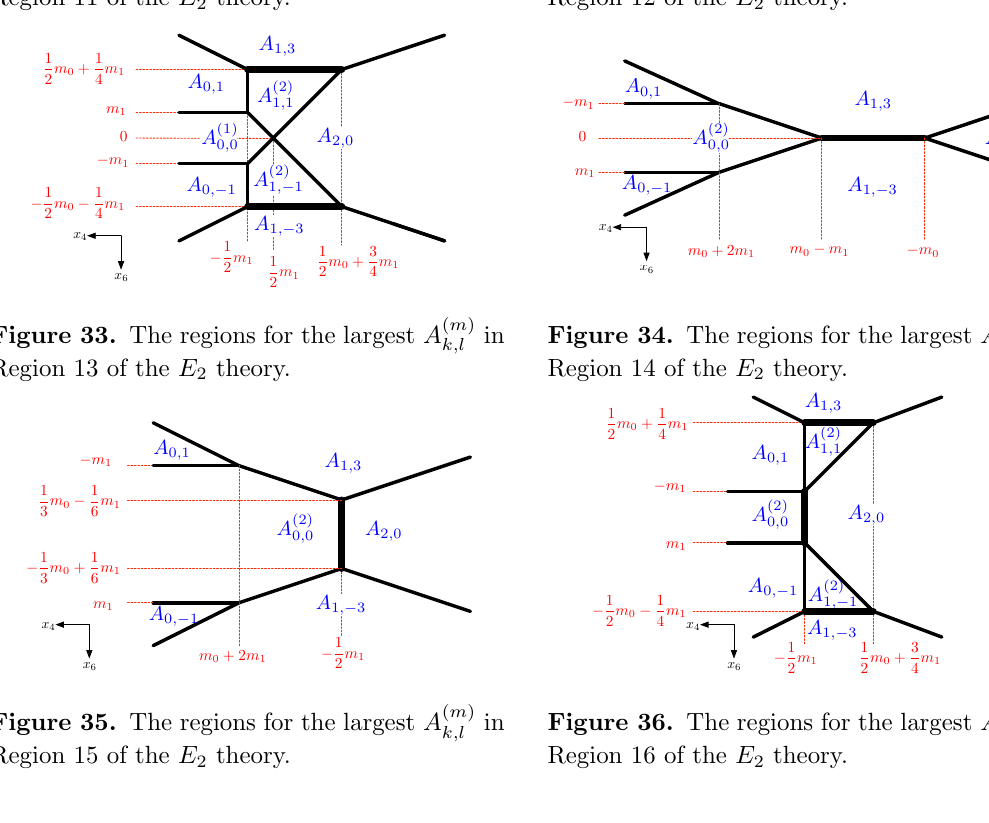
Figure 31. The regions for the largest A ( m ) Region 11 of the E 2 theory.